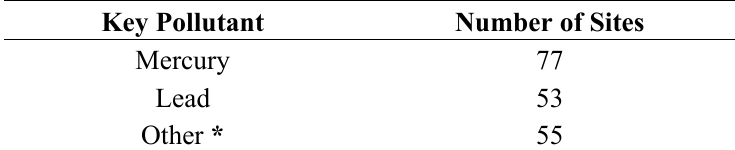
Table 1. Breakdown of contaminated sites in Ghana found in the TSIP database by key